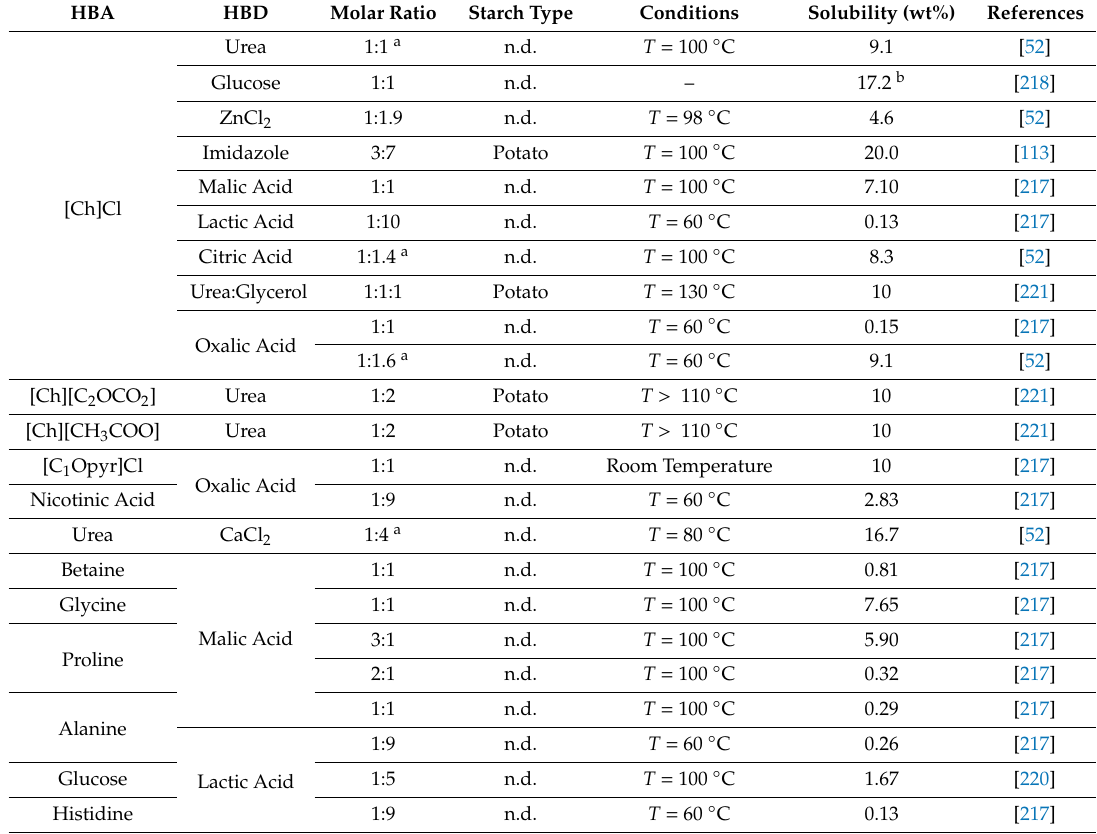
Table 7. DESs reported to dissolve starch, starch solubility and conditions applied.